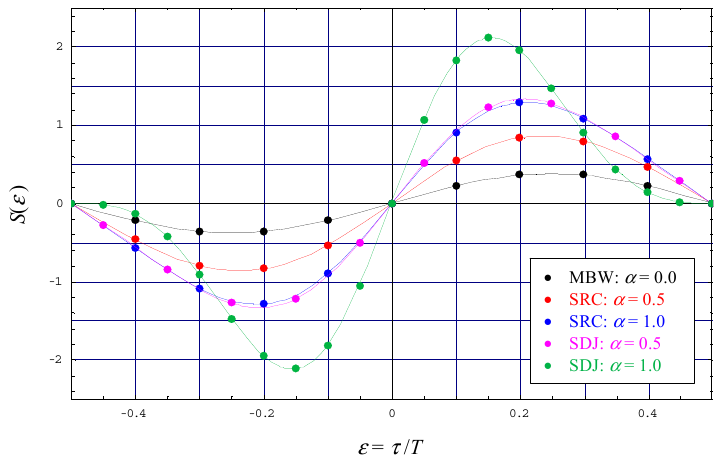
Figure 4. S-curves for dual-filter solutions (4-PAM).